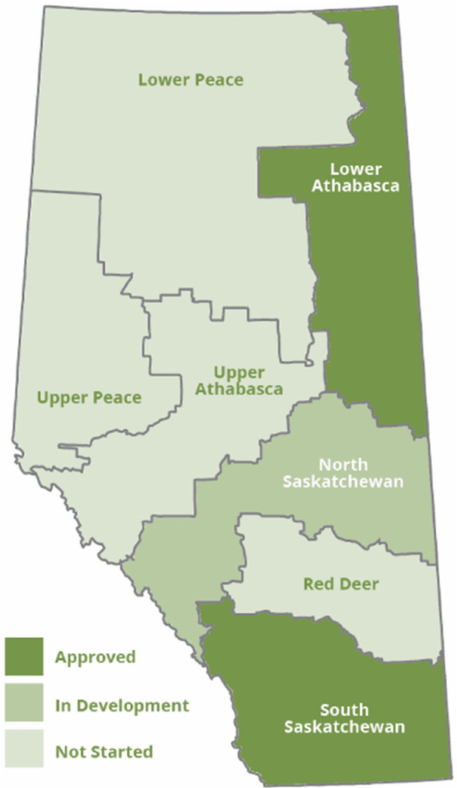
Figure 4. Alberta’s seven regions for land use planning